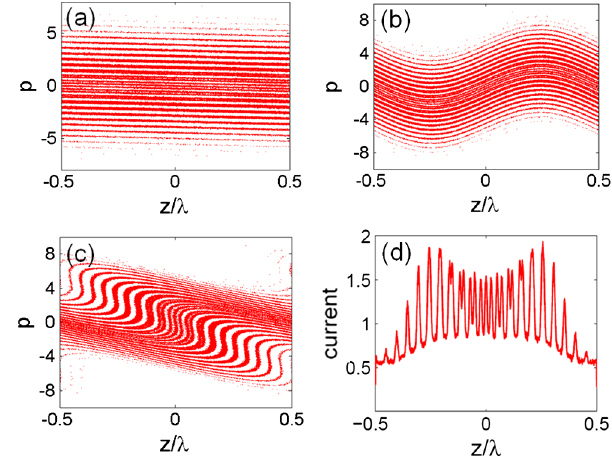
FIG. 2. Evolution of the longitudinal phase space in EEHG scheme: (a) after the first strong chicane; (b) after the second modulator; (c) after the second weak chicane; (d) density distribution after the second